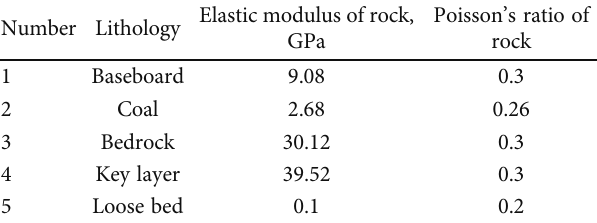
Table 2: Rock mechanics